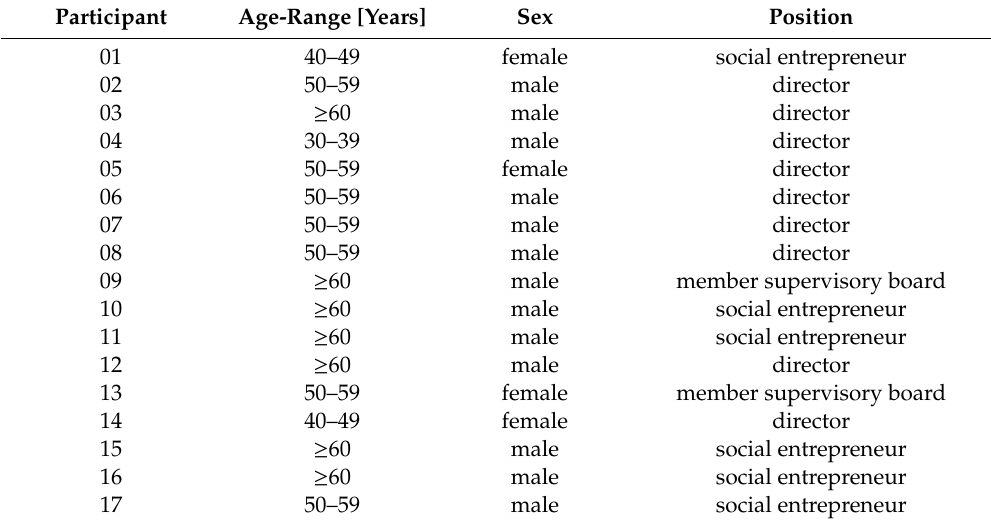
Table 1. Overview of the